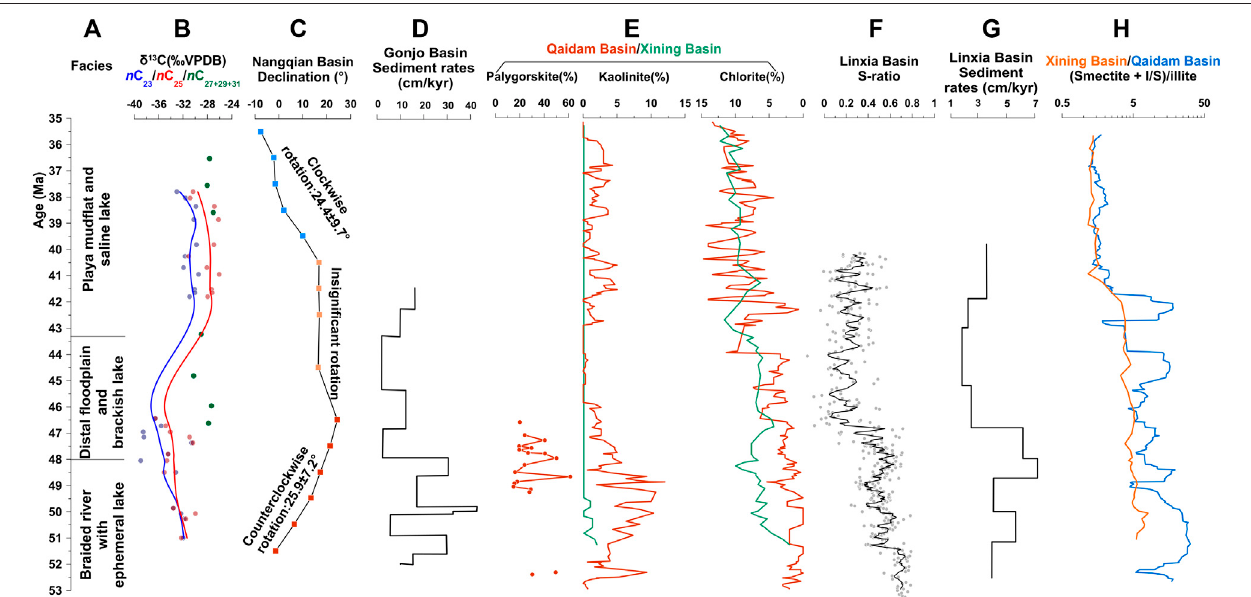
FIGURE5| SummarizedpaleoclimaticrecordsoftheEoceneintheTibetanPlateau. (A) sedimentaryfaciesintheNangqianBasin(thisstudy); (B) redandbluedots and corresponding fi tted curve (0.4 span for n C 23 and 0.55 span for n C 25 ) indicating the δ 13 C of mid-chain alkanes n C 23 and n C 25 from the Nangqian Basin (this study), and the δ 13 C values averaged over the three long-chain alkanes n C 27 , n C 29 and n C 31 from the Qaidam Basin (Sun et al., 2020); (C) Tectonic rotational history of the northeastern central TP, based on mean declination of every 1 Ma stratigraphic interval of the NB (Zhang et al., 2020); (D) the sediment accumulation rates of the Gonjo Basin (Li et al., 2020); (E) Clay mineral assemblages in the Qaidam Basin and Xining Basin, respectively (Ye et al., 2018; Fang et al., 2019) (3-point running averages for kaolinite and chlorite); (F) S-ratio for the DHJ section in the Linxia Basin (Feng et al., 2021); (G) the sediment accumulation rates of the Linxia Basin (Feng et al., 2022); (H) (Smectite + I/S)/illite ratios in the Hongliugou and Xiejia sections in the Qaidam and Xining Basins, respectively (Fang et al.,